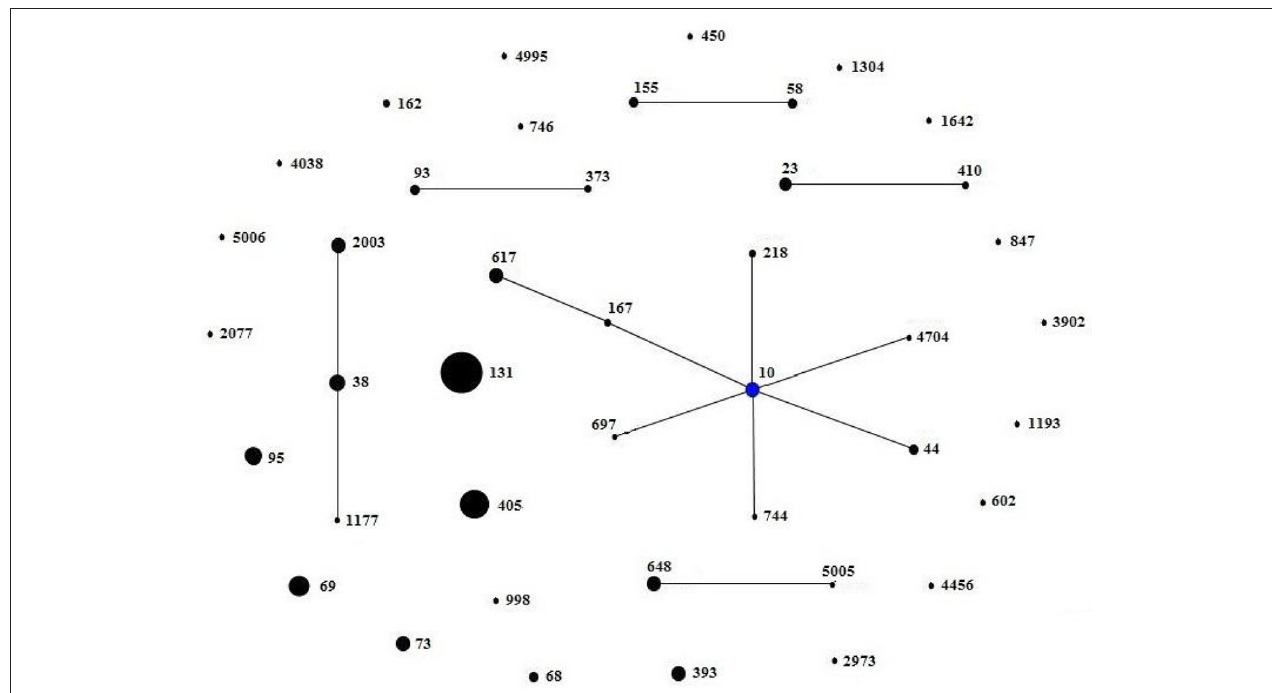
FIGURE 2 | Minimum spanning tree constructed based on the MLST profiles of ESBL-producing E. coli . There were 23 singletons, 5 groups (group1: ST58, ST155; group2: ST93, ST373; group3: ST23, ST410; group4: ST2003, ST38, ST1177; group5: ST648, ST5005), and 1 clonal complex (ST617, ST167, ST10, ST44, ST218, ST744, ST697, ST4704), which was radial. The blue dot in it indicated putative founder. The area of each black circle corresponded to the prevalence of the ST in the MLST data of this study.